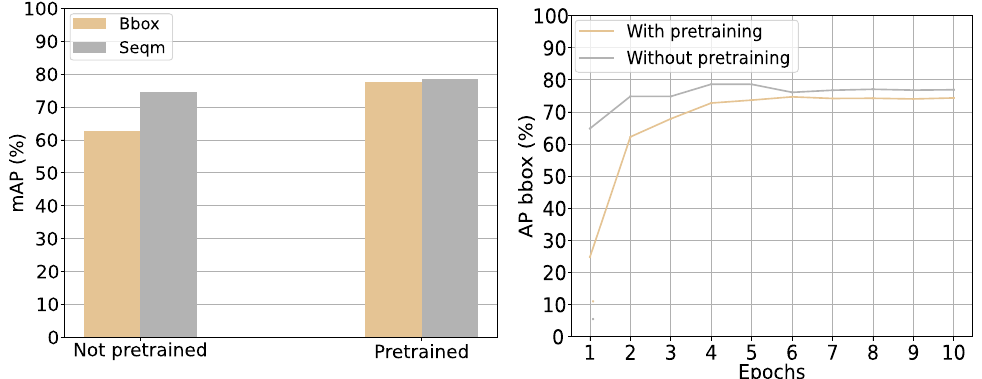
Figure 19. ( Left ) mAP for the best performing model. The best performing model was found based on the plot on the right. Pre-trained model has been trained for 5 epochs, not pre-trained has been trained for 6 epochs. ( Right ) mAP when tested on the test set over